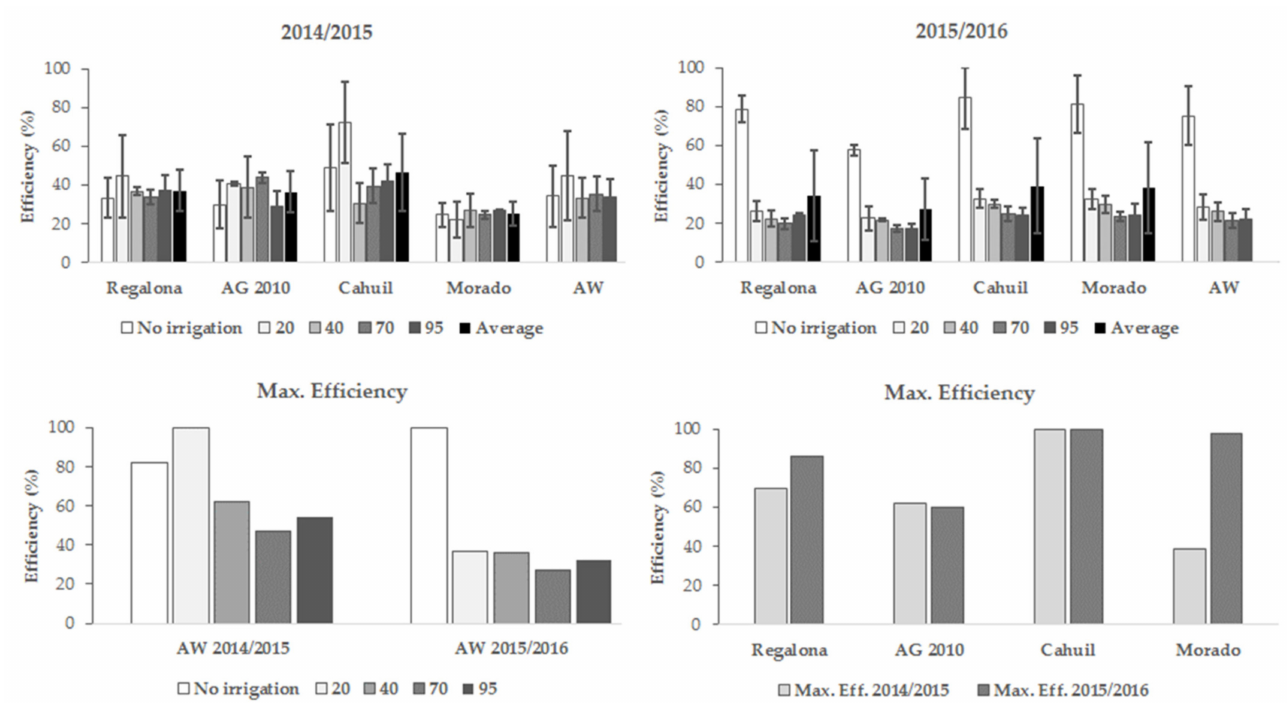
Figure 4. Average technical efficiency in seed yield in quinoa genotypes subjected to different water deficit conditions in 2014/2015 and 2015/2016